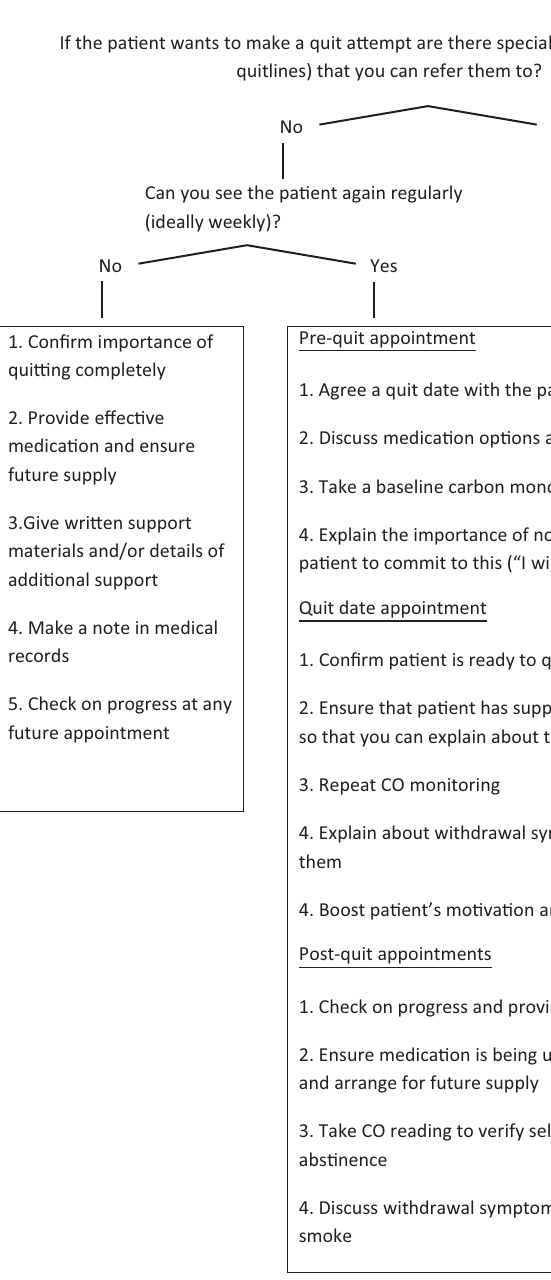
Fig. 1 Deciding what smoking cessation interventions you can